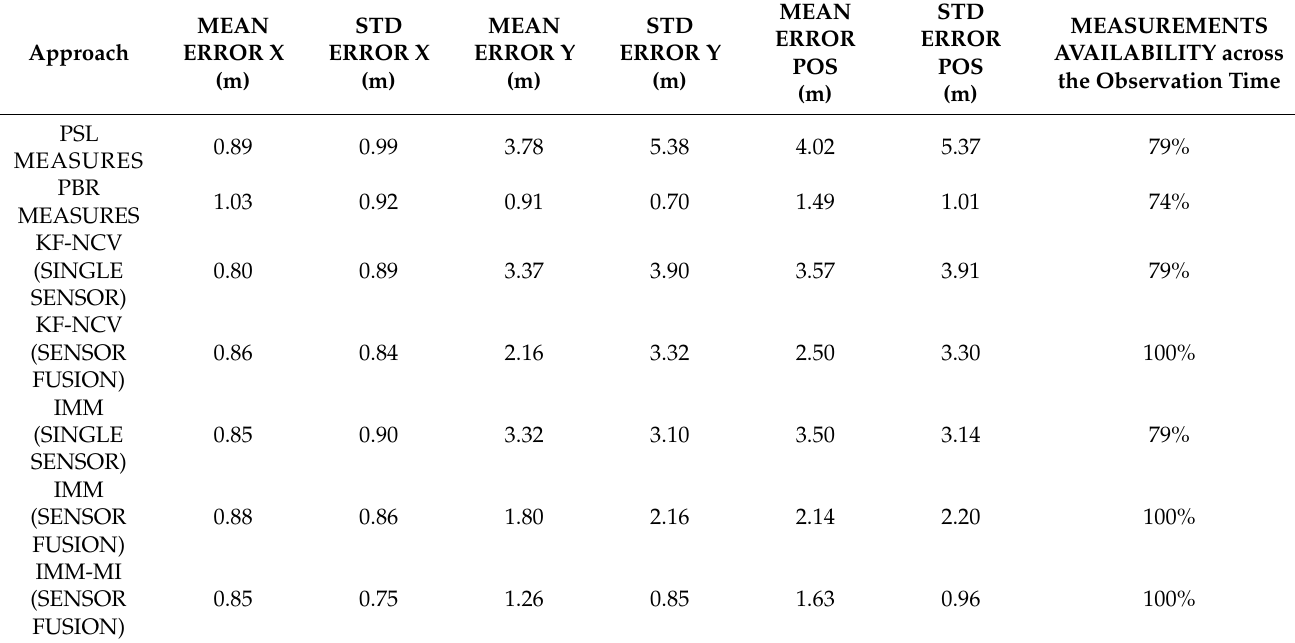
Table 6. Comparisons of the performances achieved by the different tracking techniques in the human target case.